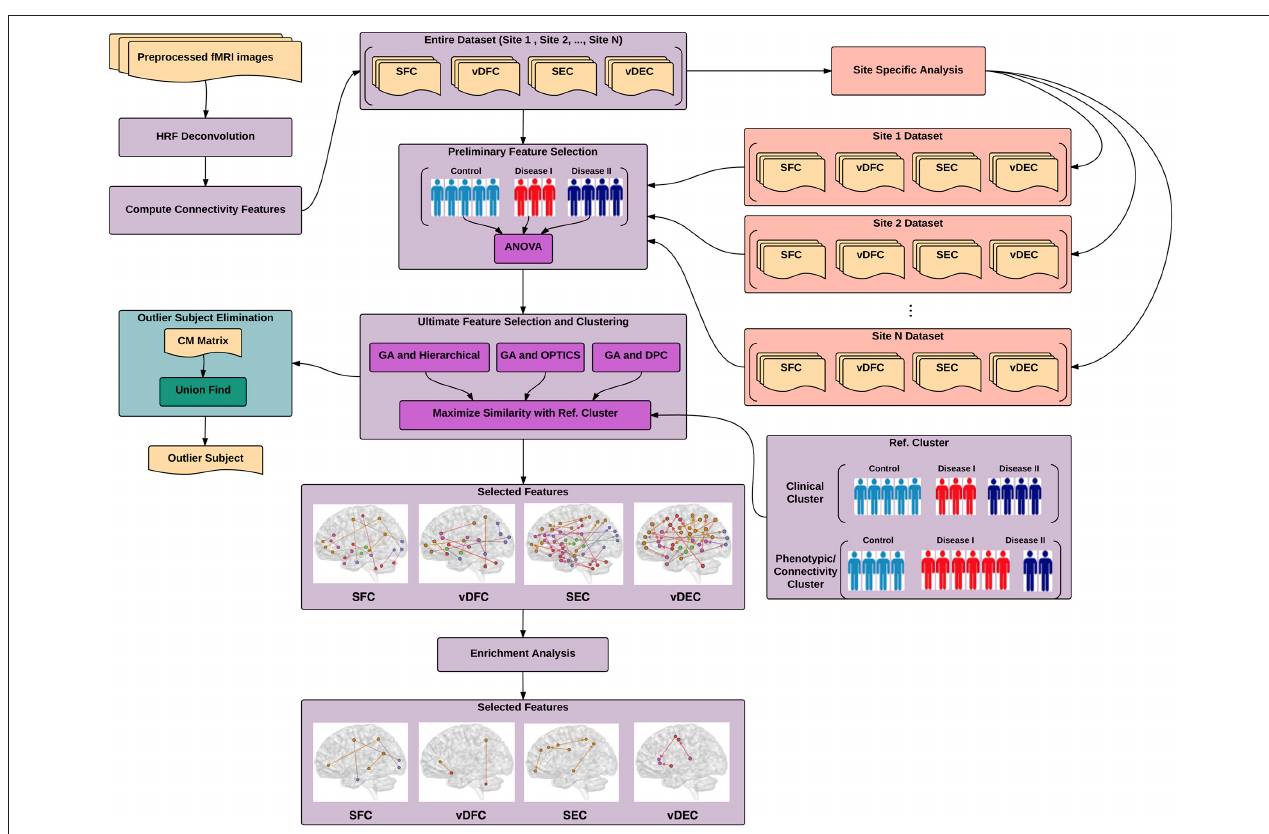
FIGURE 1 | Illustration of proposed pipeline for identifying different brain-based disorders using unsupervised clustering methods. The main pipeline is depicted in purple color along with two supplementary analyses, site-specific analysis in salmon color and outlier subject elimination in green color. SFC, static functional connectivity; vDFC, variance of dynamic functional connectivity; SEC, static effective connectivity; vDFC, variance of dynamic effective connectivity; HRF, hemodynamic response functional; GA, genetic algorithm; DPC, density peak clustering; OPTICS, ordering points to identify the clustering structure: clustering algorithm; CM, co-association